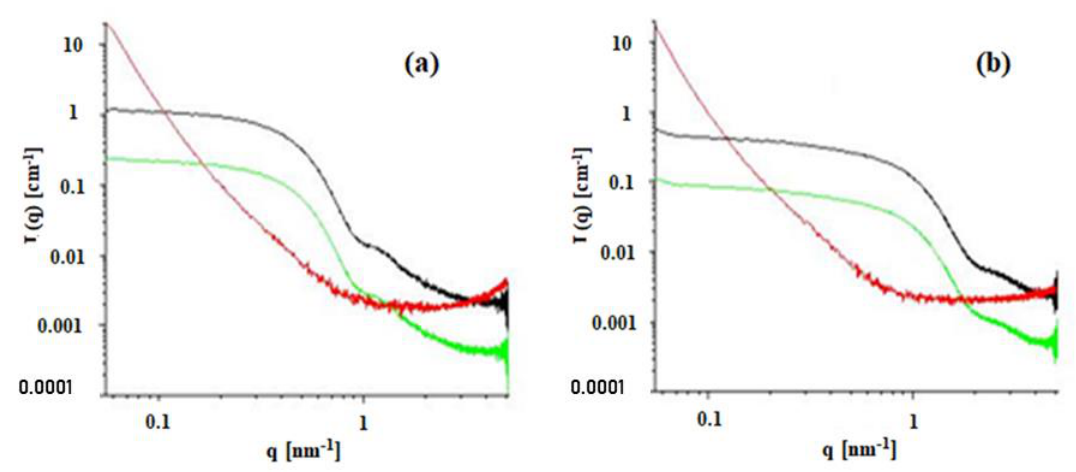
Figure 7. Scattering curves on absolute scale for HPMC-based MBGs (System C, red curves) and microemulsions with 0.05 M ( a ) and 0.2 M ( b ) AOT (black curves). A factor of 0.2 was applied to the microemulsions (green curves) to show the expected contribution of the micellar signal in the gel.